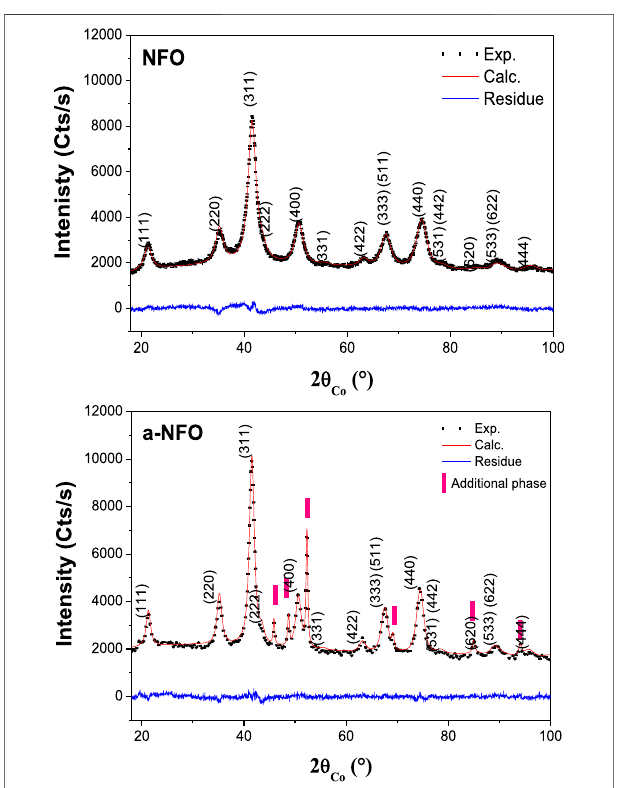
FIGURE1| Experimental (scatter)and calculated (redline)XRDpatterns of NFO and a-NFO. The difference between the calculated and the experimental diffractograms is plotted (blue line) for each sample to illustrate the fi t quality. For each fi t, the reached Bragg reliability factor ranges between 2 and